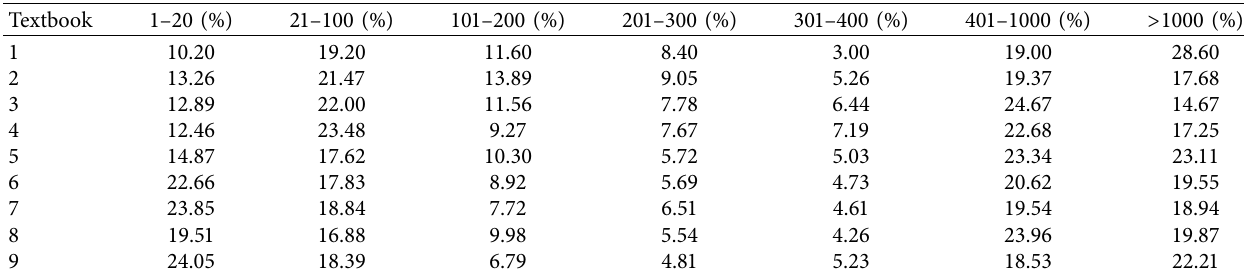
Table 6: Distribution of sentence semantic universality in each textbook (Method 2).